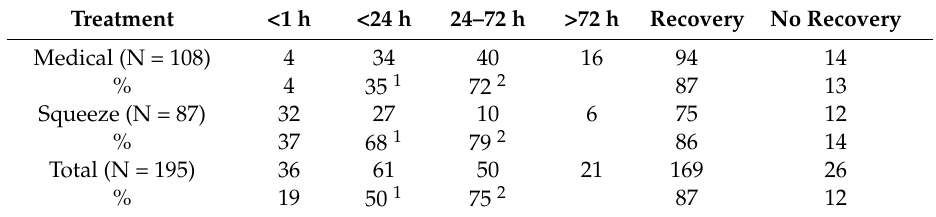
Table 1. Response to treatment at different time points post-medical and post-squeeze treatment.